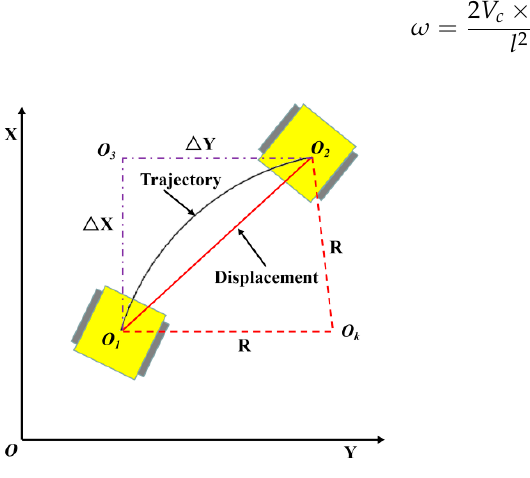
Figure 7. Schematic diagram of robot movement.